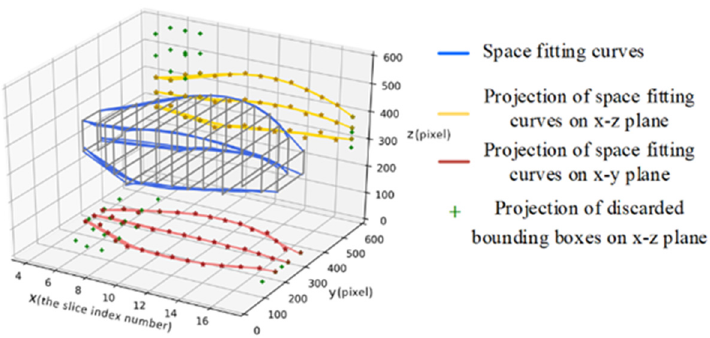
Figure7. Schematicdiagramofspatialcurvefittingandadjustment(x-directionisthesequencedirection, Figure 7. Schematic diagram of spatial curve fitting and adjustment (x-direction is the sequence y -axis and z -axis represent the width and height of the corresponding slice image, direction, y-axis and z-axis represent the width and height of the corresponding slice image, respectively).